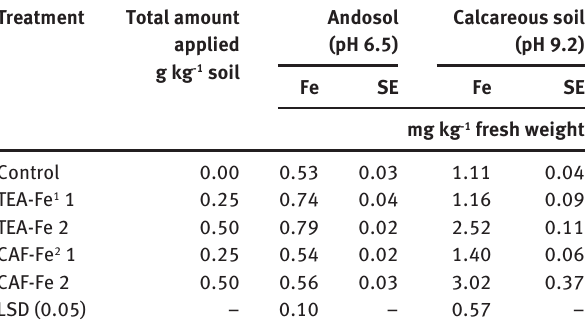
Table 3 Effect of treatments on the Fe content of the edible part of pack-choi.